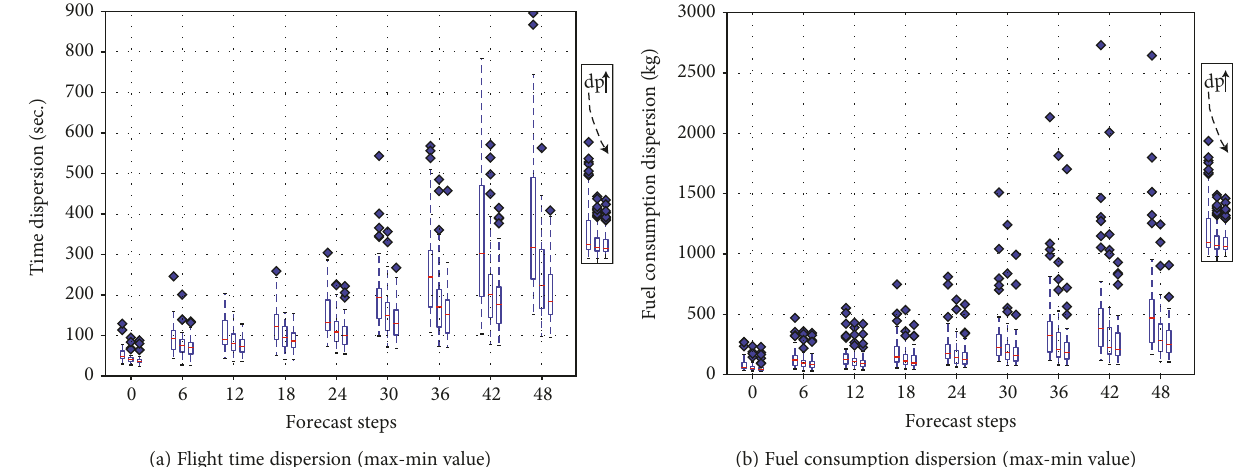
Figure 15: Aggregated dispersion boxplot multiple origin-destination (medium haul).